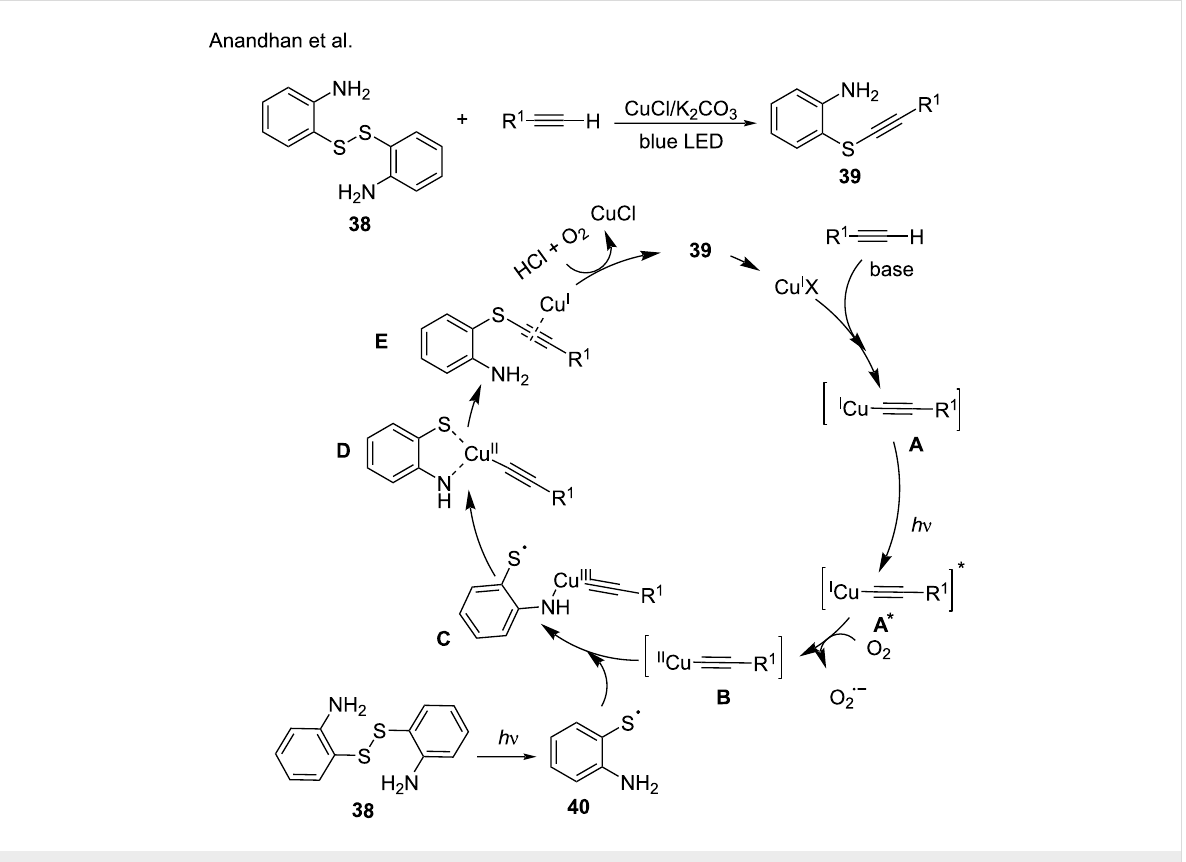
Scheme 19: Aerobic oxidative C(sp)–S coupling